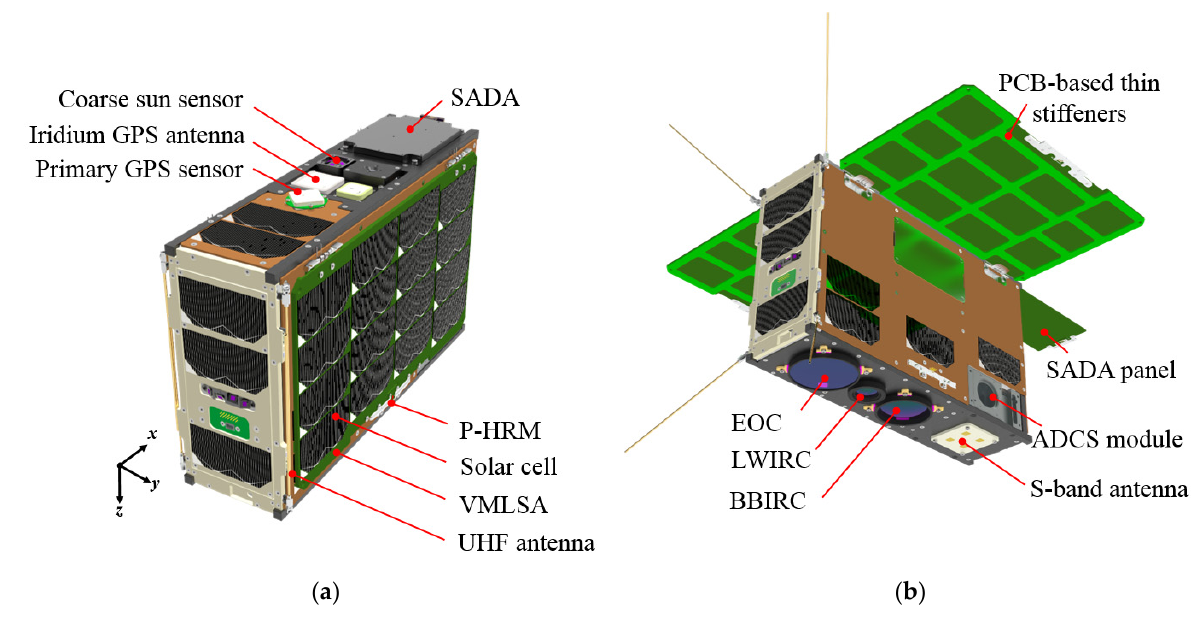
Figure 2. STEP Cube Lab-II’s mechanical configurations: ( a ) solar panel stowed and ( b ) solar panel deployed.